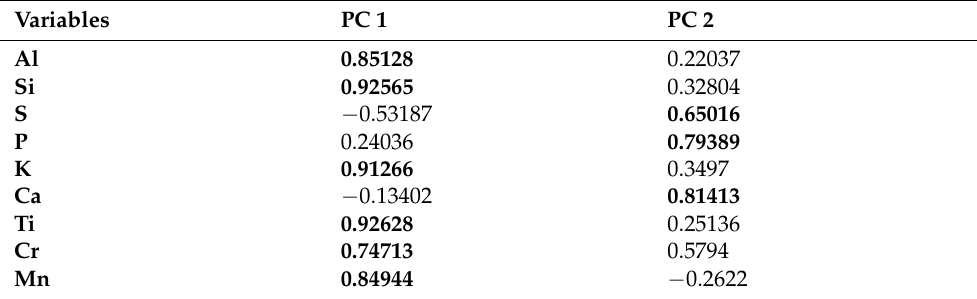
Table 3. Factor loadings for PC1 and PC2 (PC1 represents the lake phase, PC2 represents the peat phase, based on the higher values (bold) of loading